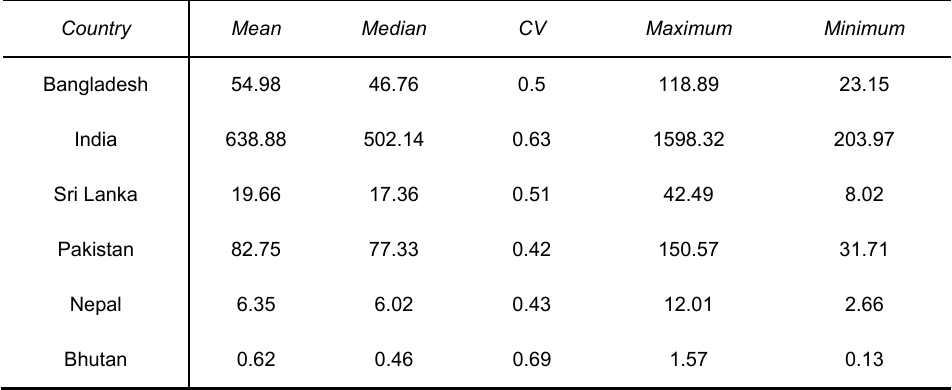
Table 1: Descriptive Statistics of GDP (constant 2005 in billion US$) in South Asia Country Mean Median CV Maximum Minimum